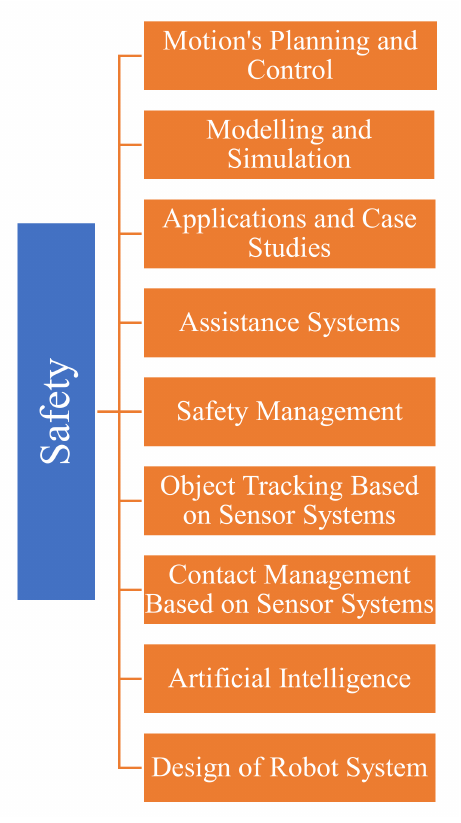
Figure 8. The research contents and themes related to safety and investigated in recent years by Gualtieri et al.